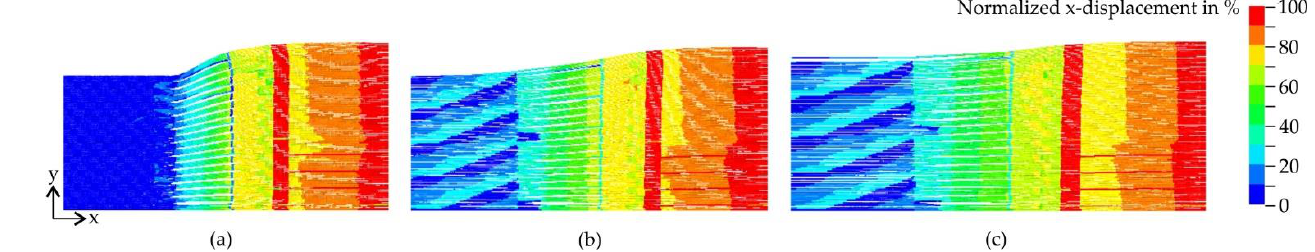
Figure 10. Simulation results of gradient fabric GW1: displacement of the warp yarns at different total strain values: ( a ) 10%, ( b ) 20%, and ( c ) 30%.